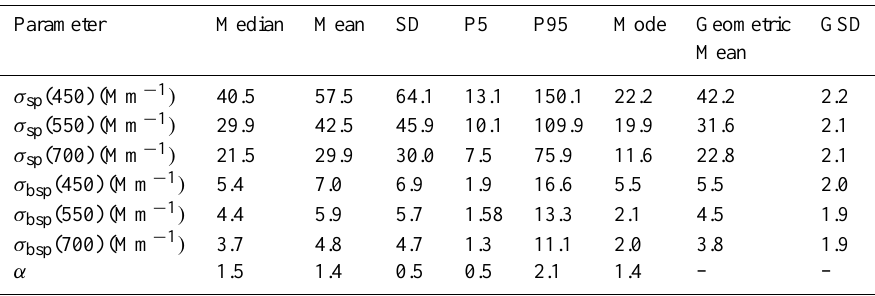
Fig. 4. Annual cycle of mean and median values of σ sp (550) ( a and b ) and α ( c and d ) as a function of the month and season. The error bars reflect the drift of the calibration constants and are added to the mean values. The respective quartiles (P25 and P75) are also shown. In the case of the box charts, P5 and P95 are also included. Table 3. Basic statistical parameters of σ sp (λ) , σ bsp (λ) and α for the period of 2002–2008. The latter doesn’t have GSD because its frequency distribution is not log-normal. Parameter Median Mean SD P5 P95 Mode